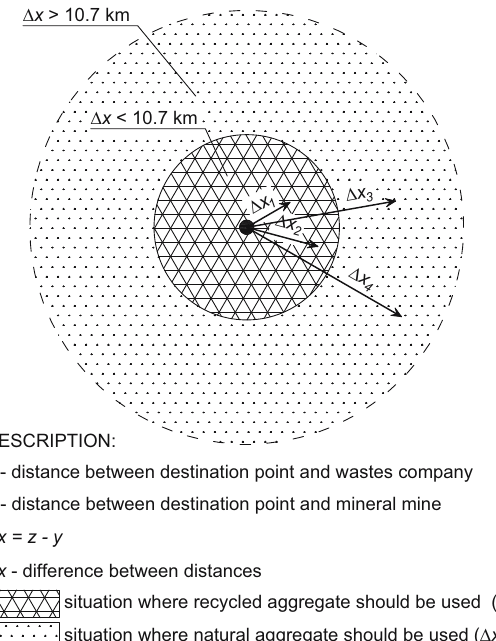
Figure 10: Summary of the calculations and economic performance of the recycled fi ne aggregate used in the epoxy resin coatings. The scheme presents the type of aggregate that should be used in epoxy resin with regards to the distance from the aggregate source to the destination